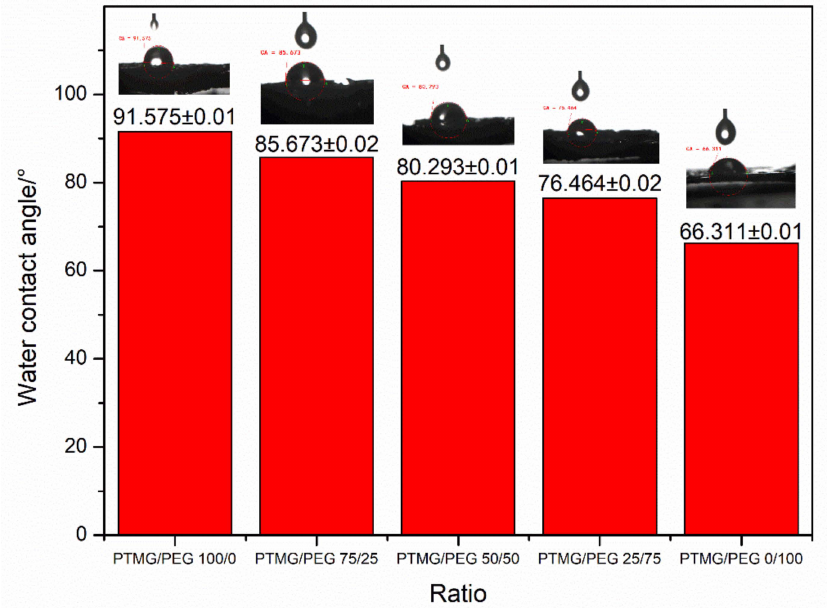
Figure 7. Water contact angle of PTMG / PEG porous sca ff old materials with di ff erent